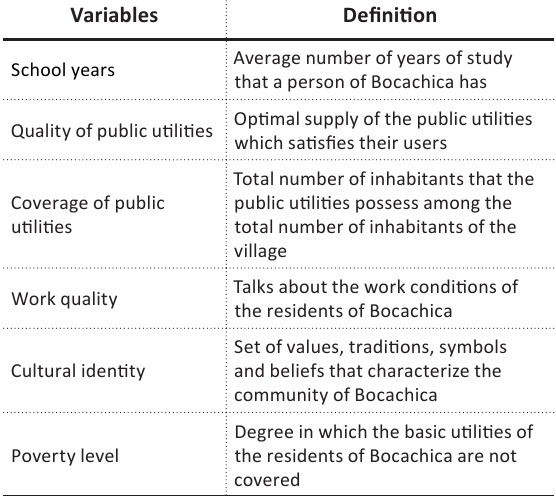
Table 3. Sociodemographic dimension Source: Elaborated by the